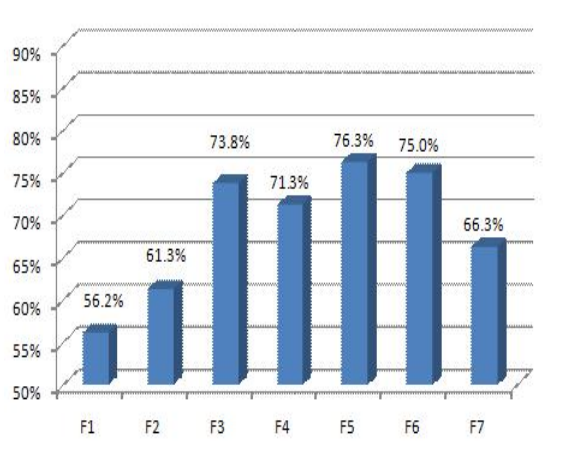
Fig. 5. Classification accuracy of each feature set.(Source: findings from the experiments of this study)